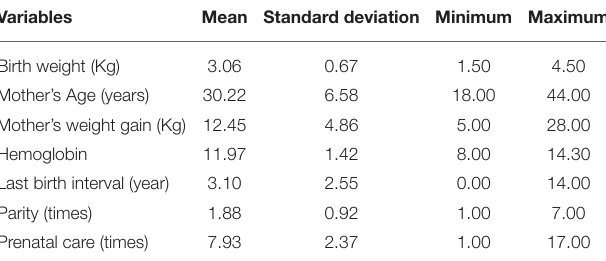
TABLE 4 | Summary statistics for continuous independent variables of Birth Weight